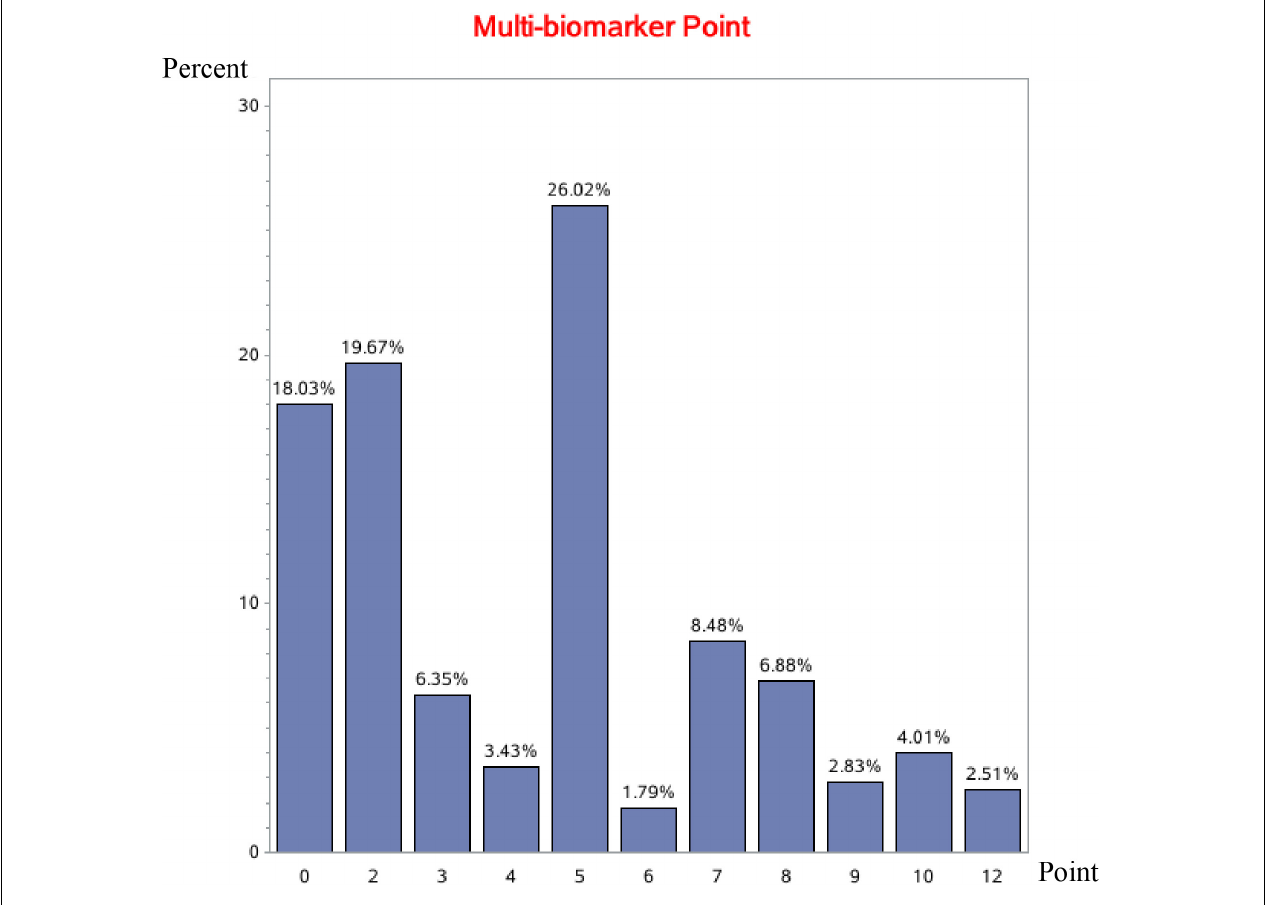
FIGURE 1 | Multi-biomarker point distribution in the overall